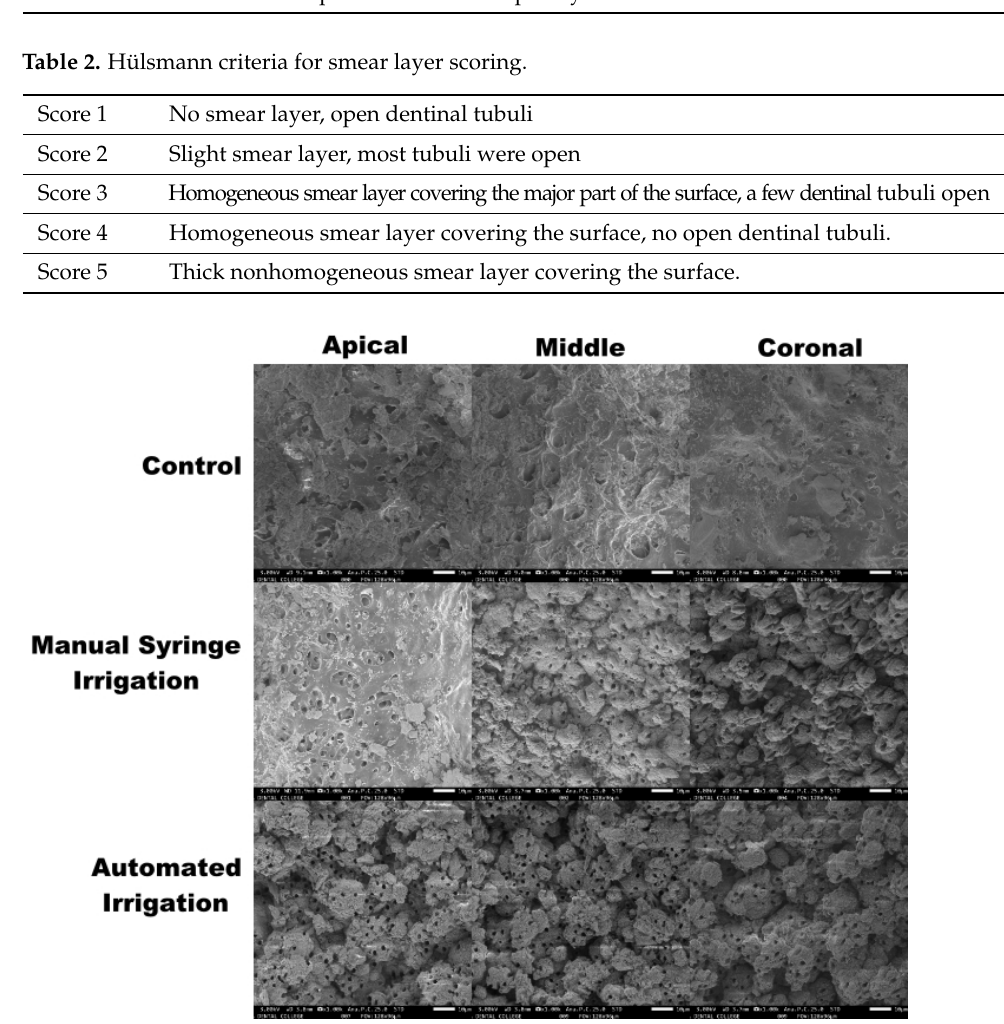
Figure 1. Scanning electron microscope images of the apical, middle and coronal third following irrigation of the control group, manual syringe irrigation group and automated irrigation group (1000× magnification).